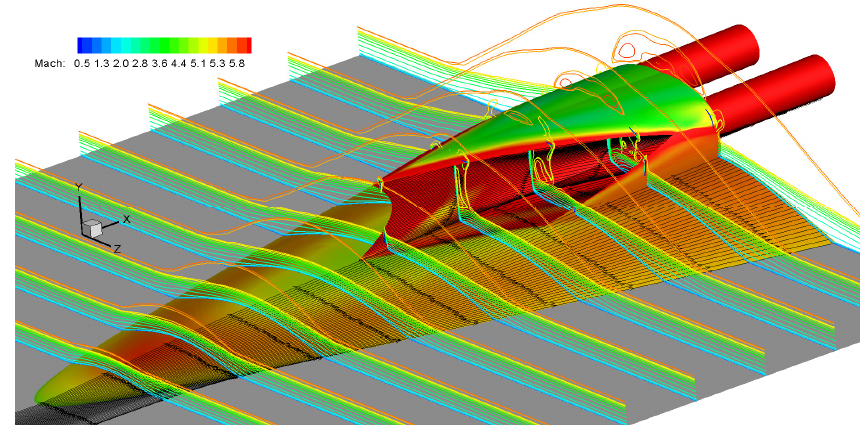
Figure 13. Flow structure of the new spillage ‐ adaptive bump inlet.